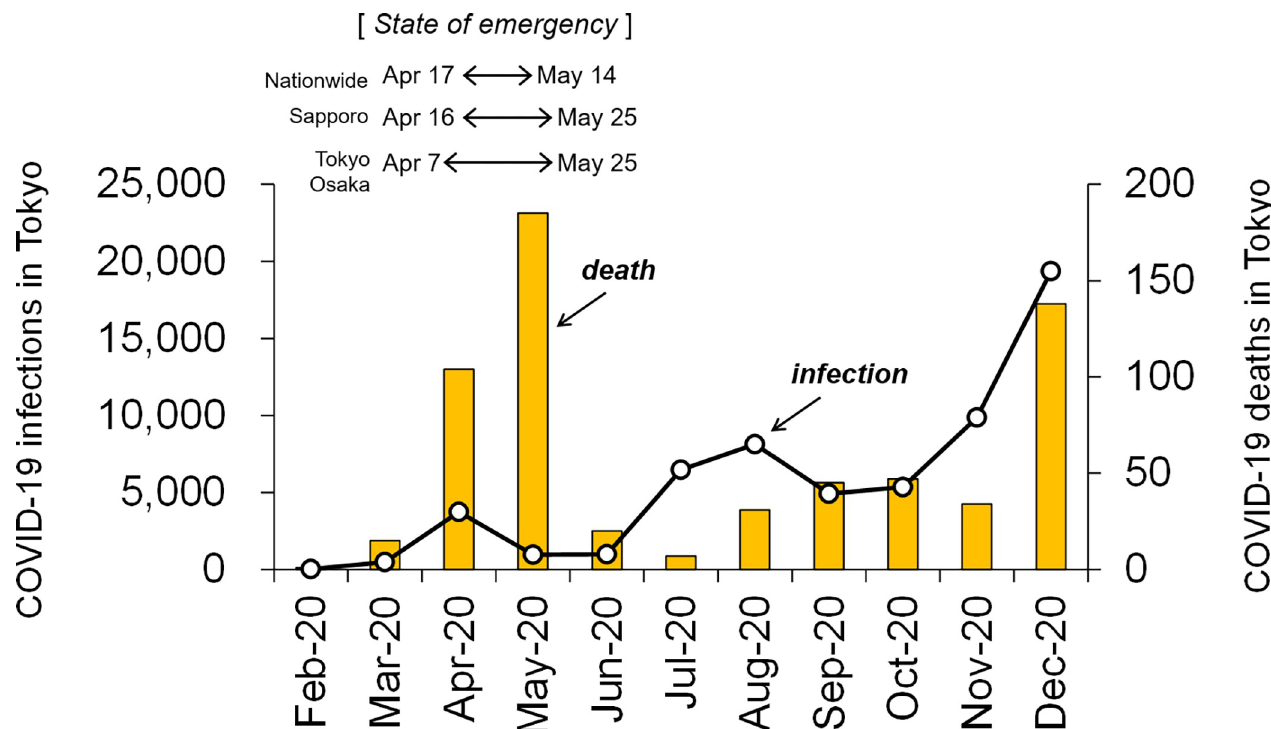
Fig 2. Monthly variations of COVID-19 infections and deaths in Tokyo 23 wards from February to December 2020. The Japanese government declared a state of emergency restricting people’s daily activities from April 7 (Tokyo and Osaka) and 16 (Sapporo) to May 25 in 2020.